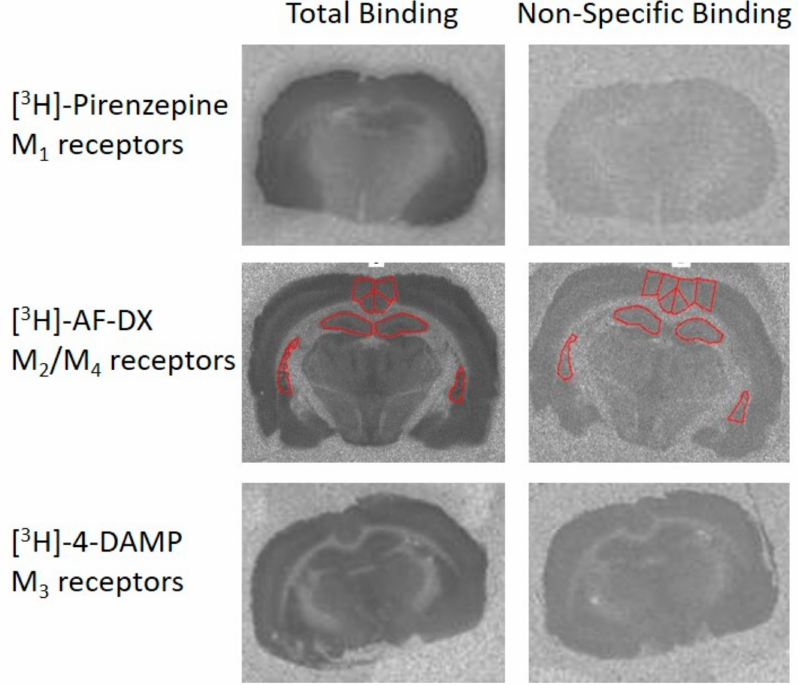
Figure 2. Representative autoradiographic images showing total binding (left panels) and nonspecific binding (right panels). Three tritiated radioligands were used with the protocols described in Section